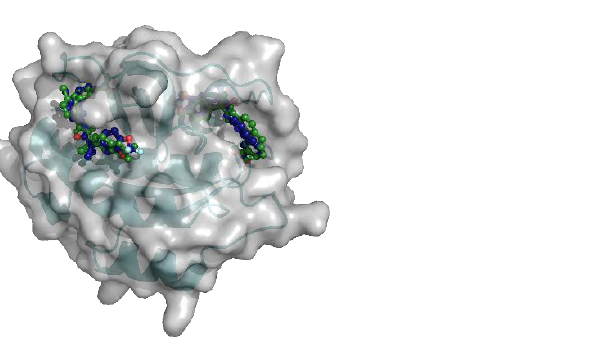
Figure 5. Docking results of Lumacaftor to RAB7A (PDB 1T91). Pocket A is shown on the right side, pocket B on the left. The docking poses of Lumacaftor predicted by qvina-w are coloured in green, the ones by Smina in blue.